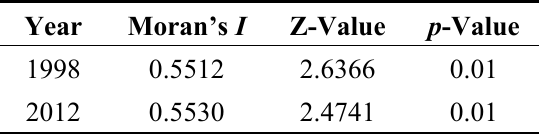
Table 2. Global Moran’s I of water footprints (WFs) of maize production in 1998 and 2012.